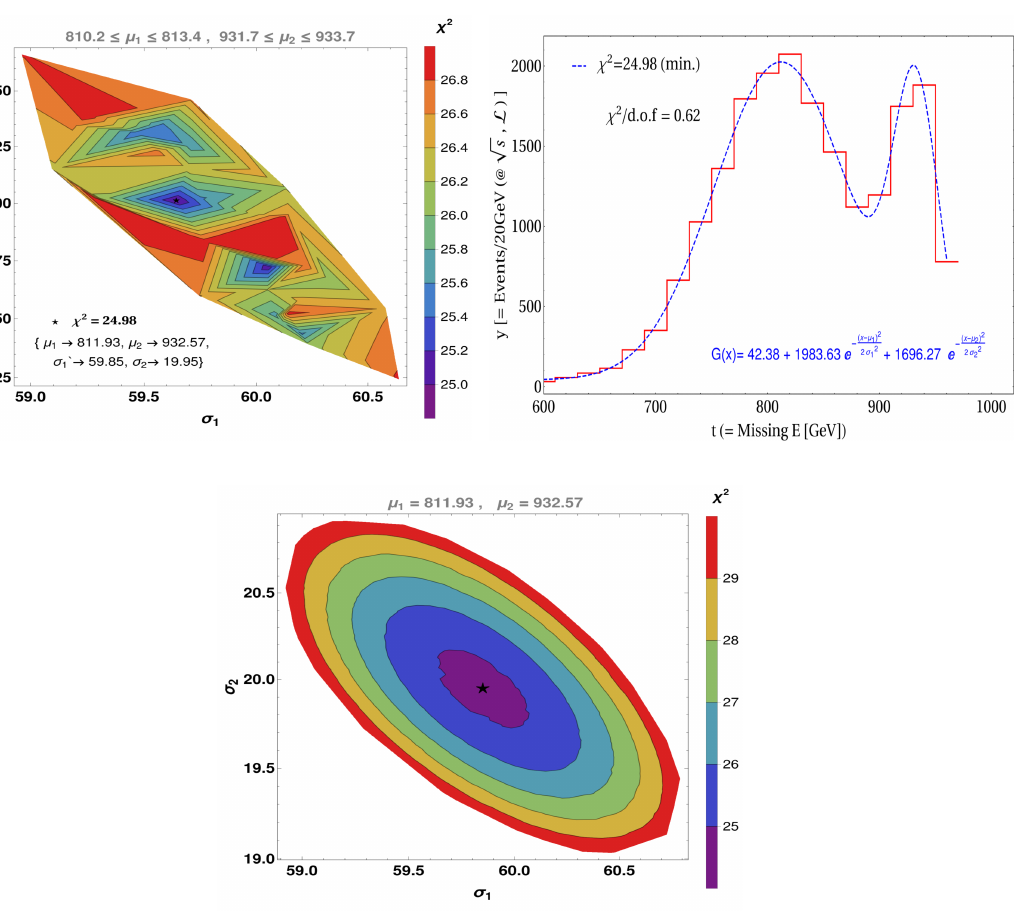
Figure 34. [Top Left] χ 2 defined by eq. (D.3) shown in different colored regions in the plane of σ for the random variation of the parameters of the two peak Gaussian function G : 1 − σ 2 { µ 1 : { 810 . 2 − 813 . 4 } , σ 1 : { 58 − 62 } ; µ 2 : { 931 . 7 − 933 . 7 } , σ 2 : { 18 − 22 }} . [Top Right] The best fit two peak Gaussian function with minimum χ 2 shown by blue dotted line, confronted with histogram data in solid red. [Bottom] The variation of χ 2 is again shown in the plane of σ keeping µ = 811 . 93 and µ = 932 . 57 fixed. The ? sign corresponds to the best fit parameters of 1 2 the Gaussian function G , which also marks minimum χ 2